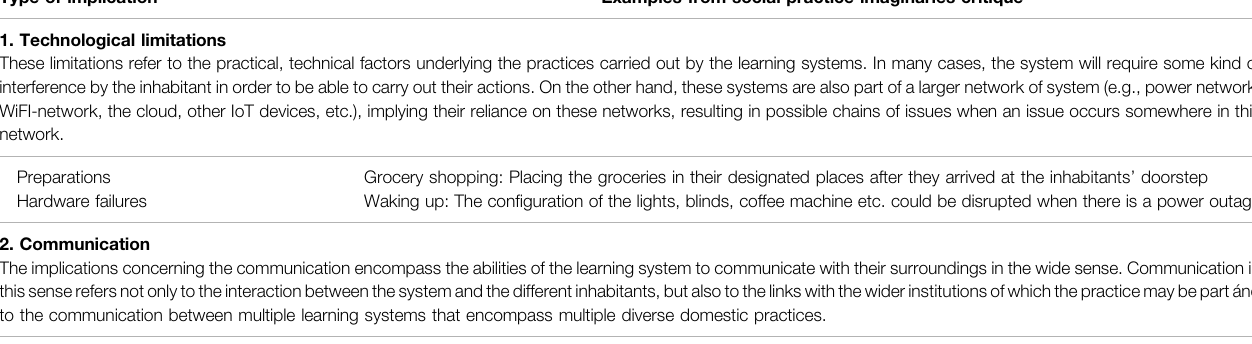
TABLE 3 | Typology of identi fi ed